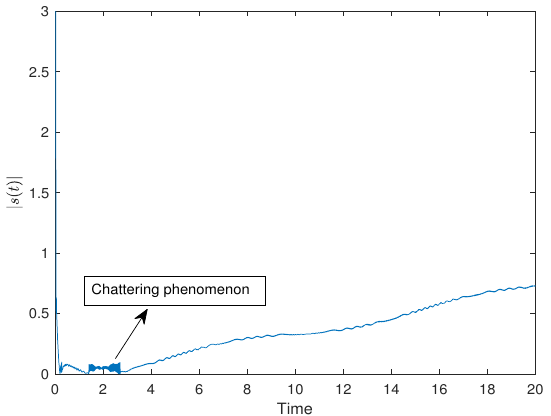
Figure 7. The chattering phenomenon is arisen in the sliding variable | s ( t ) | of implementing the control u without the boundary